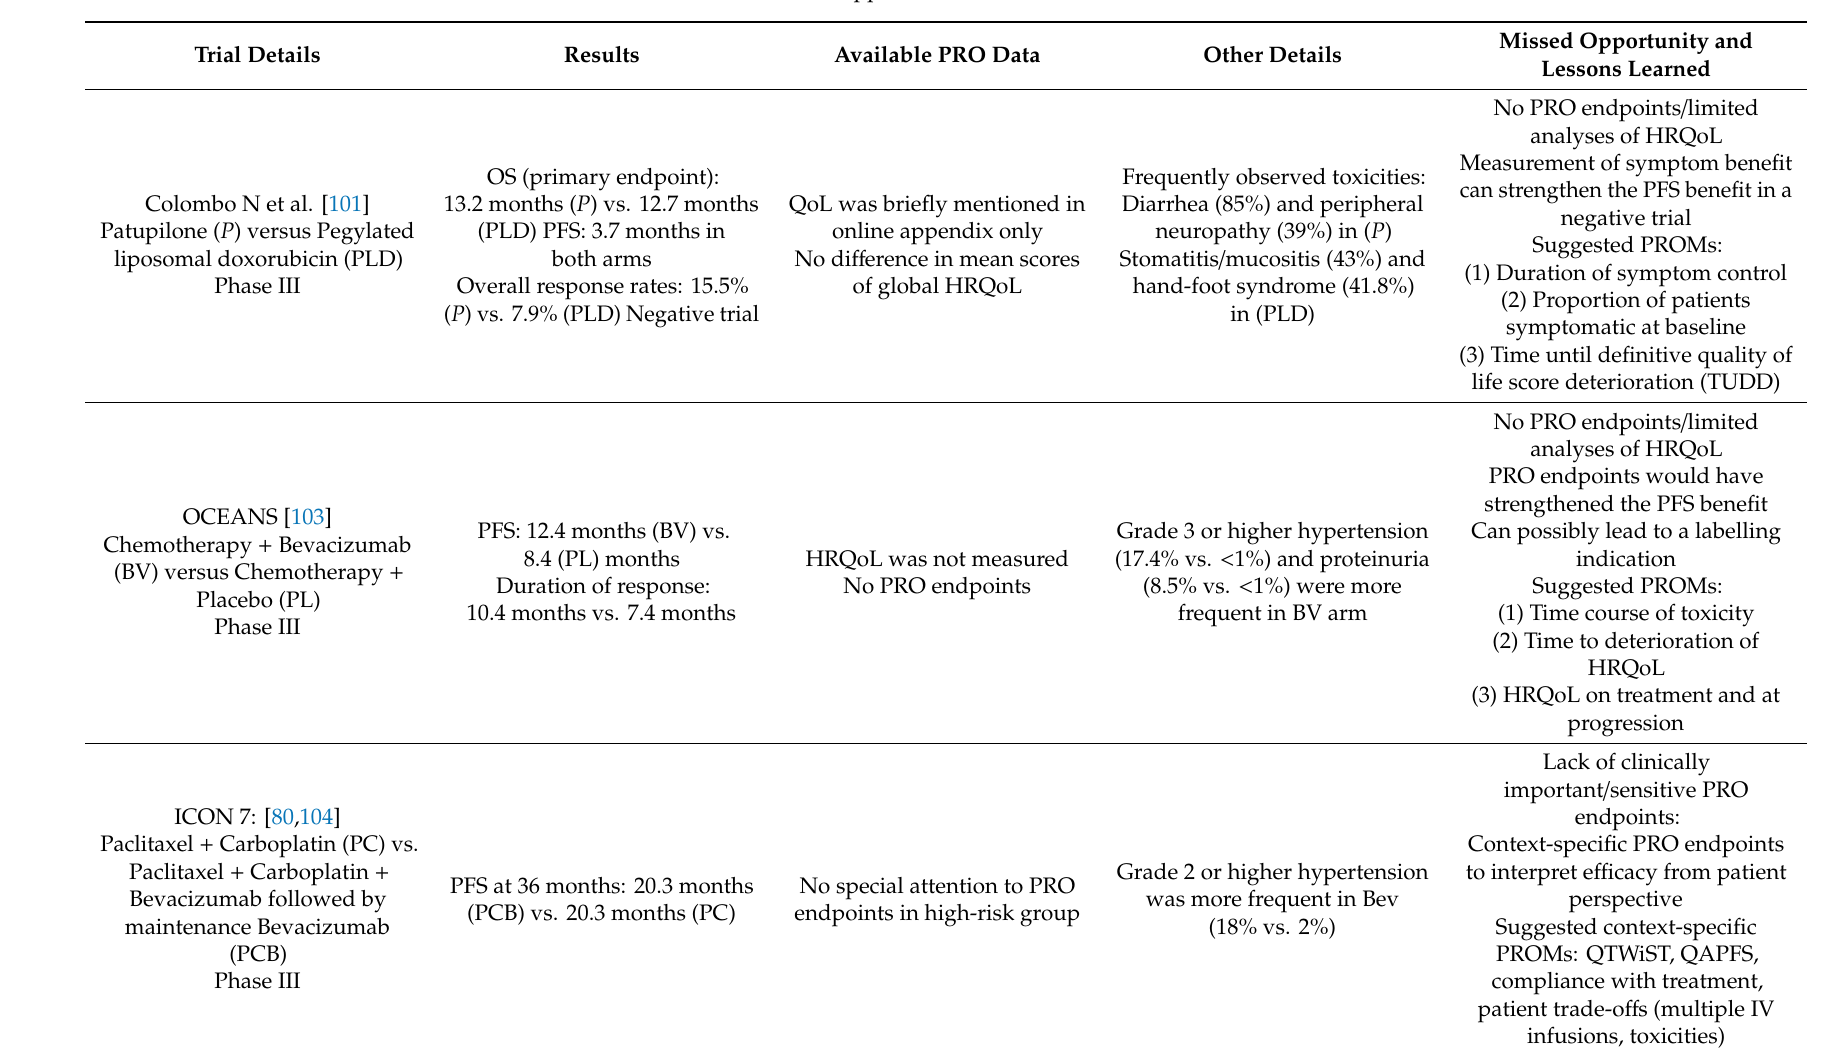
Table 3. Missed opportunities in ovarian cancer